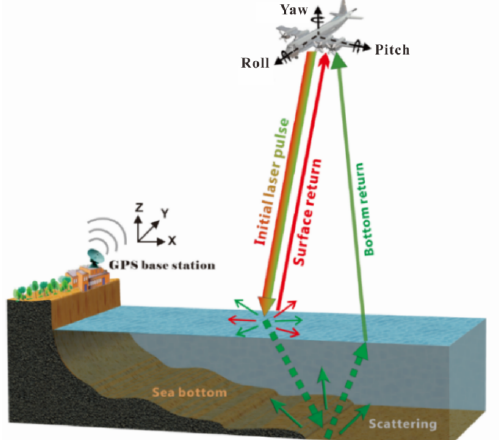
Fig 1: Dual LiDAR working